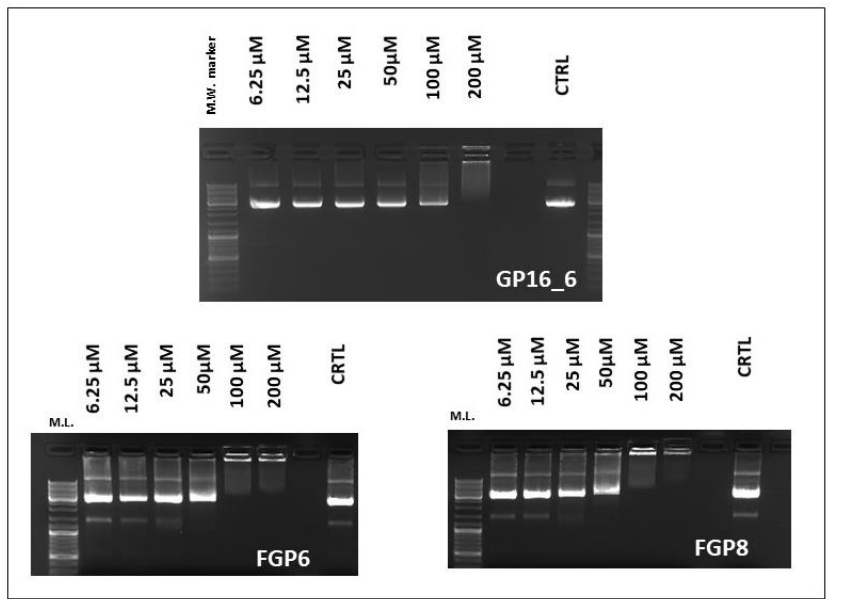
Figure 4. EMSA experiments showing complexation of GP16_6, FGP6 and FGP8 with circular plasmid pEGFP-C1. Shifting is observable as a function of concentration (μM). As a negative control, only the plasmid was used, which is completely unshifted. 100 μM cationic lipid concentration corresponds to N / P ≈ 1.